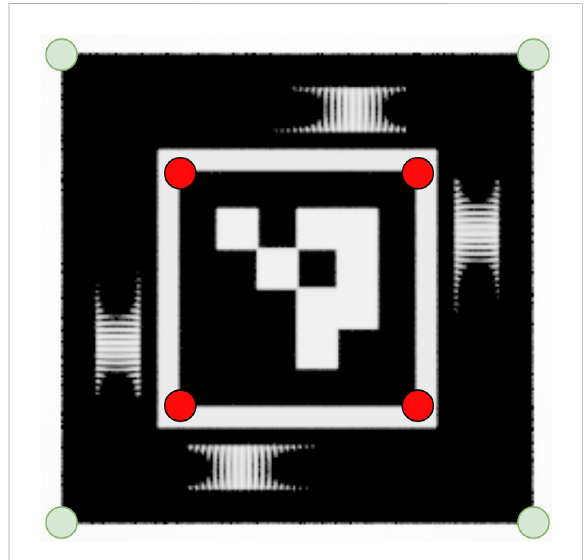
FIGURE 14 Proposed design improvements for implementation of our encoding element. The white borders of the encoding elements are removed. In addition, the corners of the end-to-end fi ducial should be used as features for input to the PnP (indicated by the green markers), instead of the internal ArUco corners (indicated by the red markers) as is the case in the current implementation. This will increase the range performance of a marker that utilises our encoding